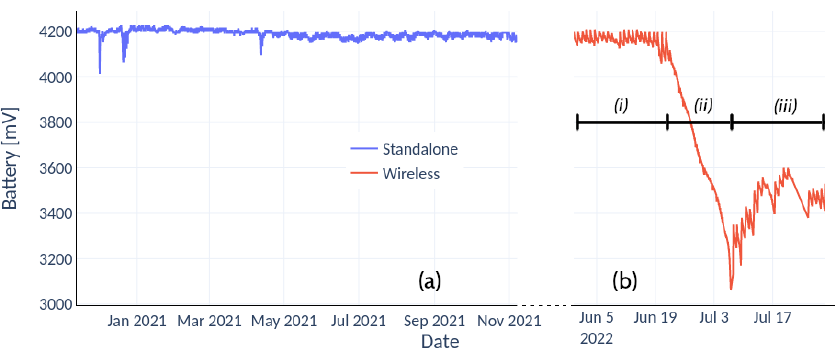
Figure 9. ( a ) Battery voltage of the IoT device in stand-alone mode storing variables every 5 minutes with full solar exposure; ( b ) voltage variation when the IoT device transmits data every minute in conditions of reduced solar exposure, (i) and (iii), and when the solar panel is cut off (ii).